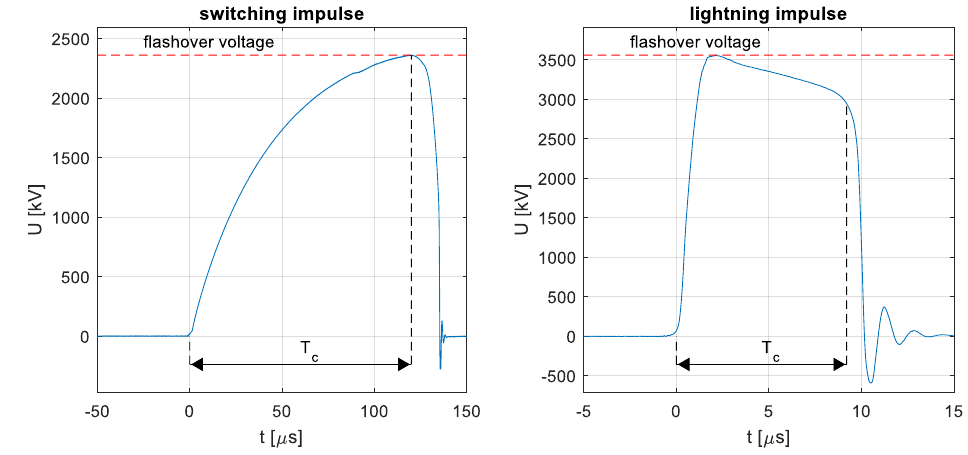
Figure 3. Examples of impulse volatge curves recorded during testing: impulse chopping typically occurred at the front of the switching impulse and at the tail of the lightning impulse.